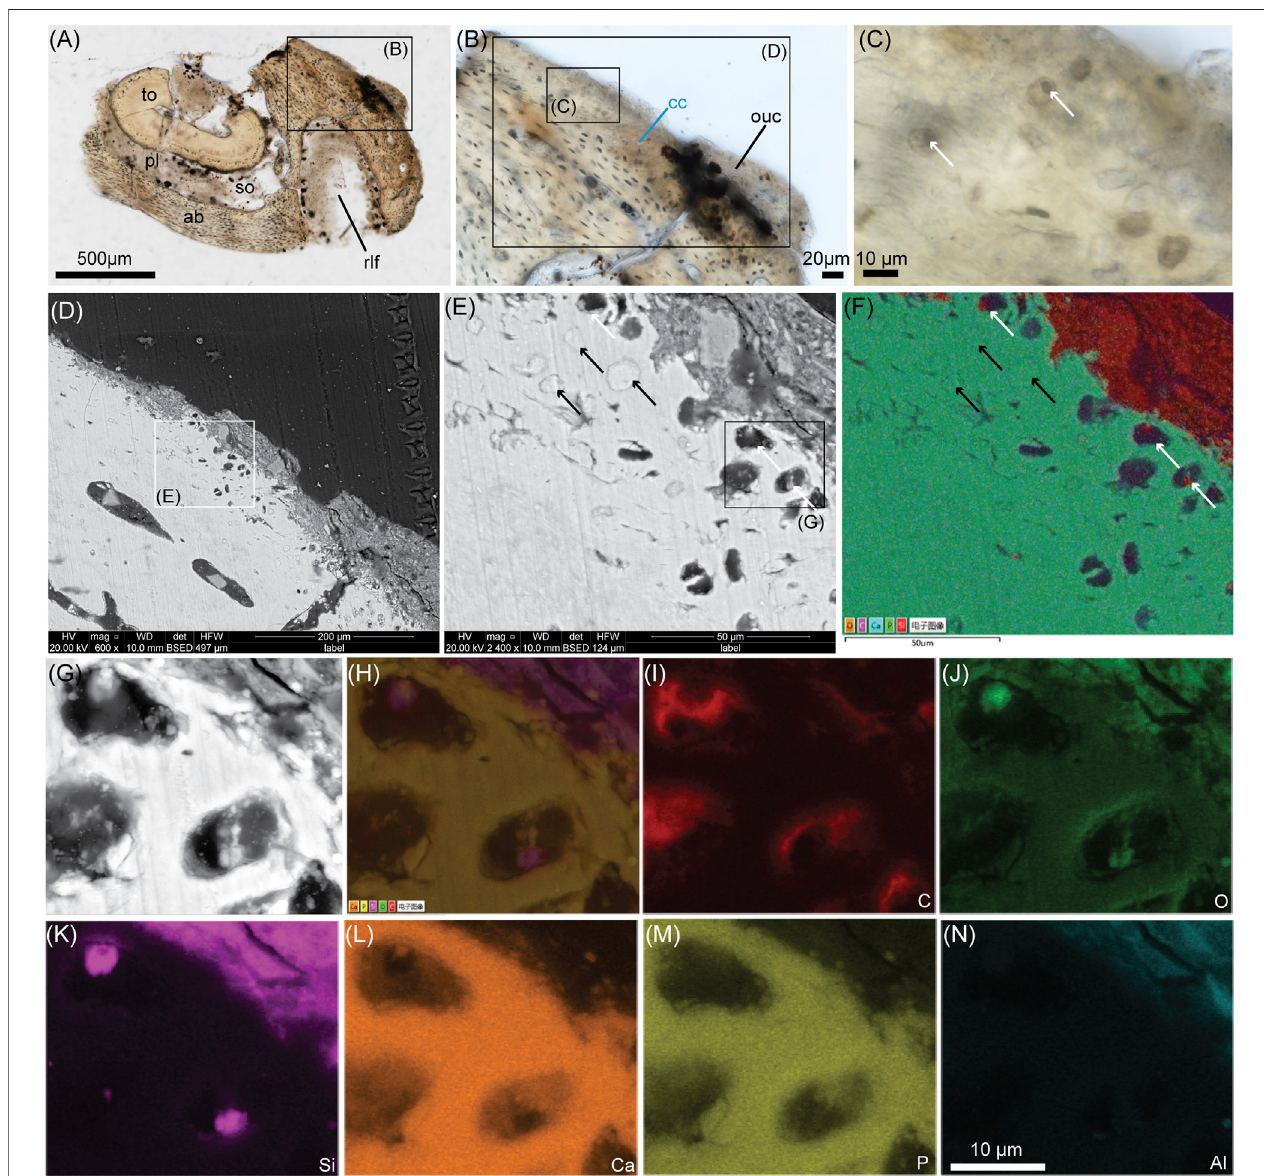
FIGURE1| Ground-sectionwithSEMandEDSanalysesofthecartilageonthedentaryof Yanornis (IVPPV13358). (A) Whole-viewofagroundsectionthroughthe rostral-mostportionofthedentaryof Yanornis throughthetooth(to)socket(so)andtherostrolateralforamina(rlf). (B) Close-uponsymphysealcalci fi edcartilage(cc)and originally unmineralized cartilage (ouc). (C) Close-up on some cc showing round chondrocyte lacunae fi lled with smaller, dark, spherical material (white arrows) which resemble cell nuclei. (D) SEM image of the large rectangle in (B) . (E) Close-up on the cc from the white square in (D) . Some lacunae are fi lled with white material of thesamecontrastastheECM(blackarrows)andothersaredarkand fi lledwithmuchsmallercircularmaterial(whitearrows),whicharetheblackspheresseenin (C) . (F) EDS mapping ofthe fi vemain chemical elements present in (E) . (G) Close-upimage ofsome chondrocyte lacunae seen inE. (H) EDS mapping ofthe fi vemain elements seen in (G) . (I) – (N) are EDS mapping of the individual elements carbon (C), oxygen (O), silicon (Si), calcium (Ca), phosphorous (P) and aluminum (Al). Additional abbreviations: ab, alveolar bone; cc, calci fi ed cartilage; pl, periodontal ligament. The scale bar is the same from (G) through (N) .